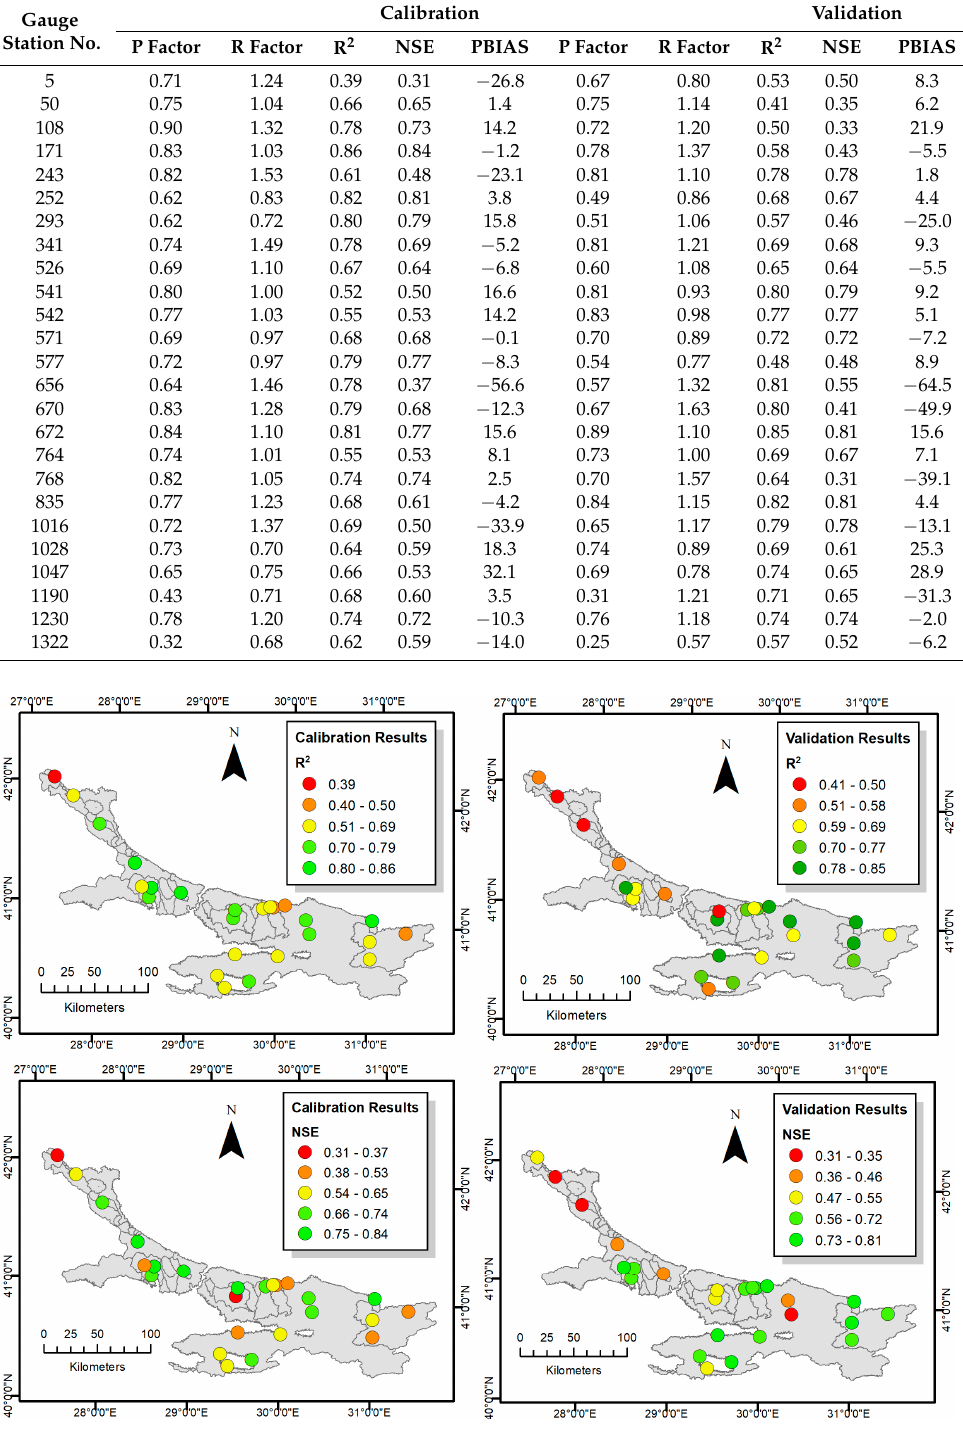
Table 4. Model performance indicators of 25 gauge stations for calibration and validation. Calibration Validation Gauge Station No.